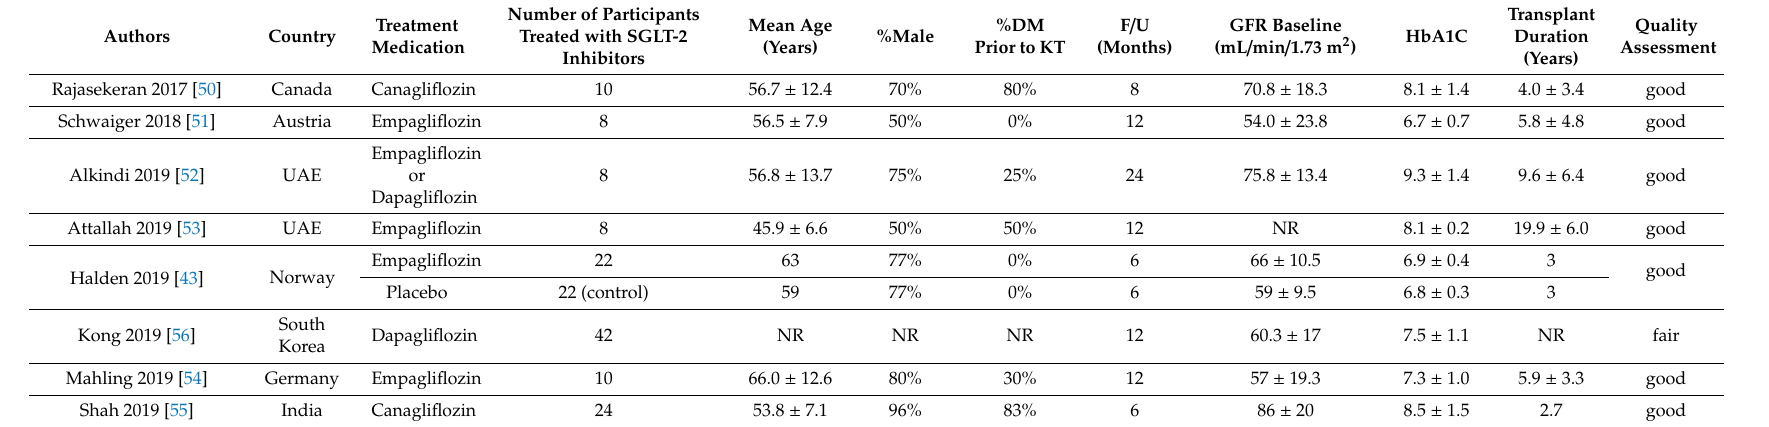
Table 1. Characteristics of the included studies in this meta-analysis analyzing the e ffi cacy and safety profiles of sodium-glucose co-transporter 2 (SGLT-2) inhibitors on treating kidney transplant recipients with post-transplant diabetes